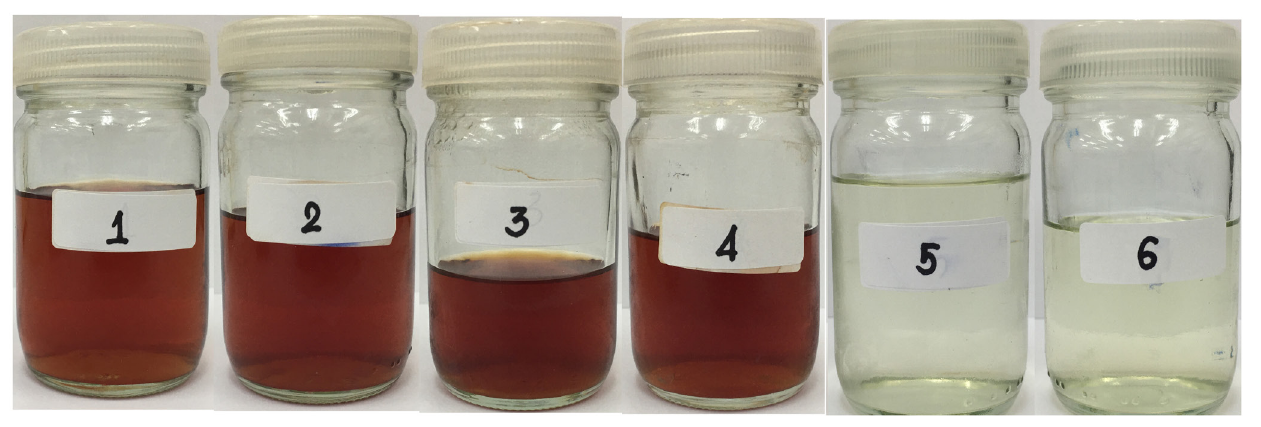
FIGURE 2 - The extraction solution using different solvents; (1) ethanol 1, (2) ethanol 2, (3) water:methanol (40:60) 1, (4) water:methanol (40:60) 2, (5) ethyl acetate 1, and (6) ethyl acetate 2.